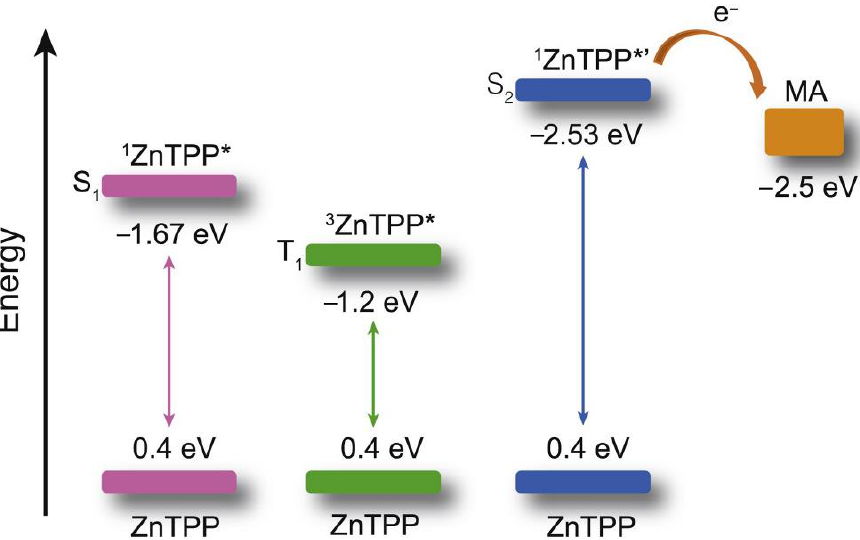
Figure 6. Schematic illustrations of the excited-state redox potentials of ZnTPP as well as monomer versus ferrocene + /ferrocene in CH 3 CN (the redox potential of TMPTA was hypothetically equal to that of MA) and the dynamic electron transfer between 1 ZnTPP*’ and monomer, in which the symbol * refers to the excited state. Reprinted with permission from ref. [95]. Copyright 2020 Elsevier Ltd. All rights reserved.